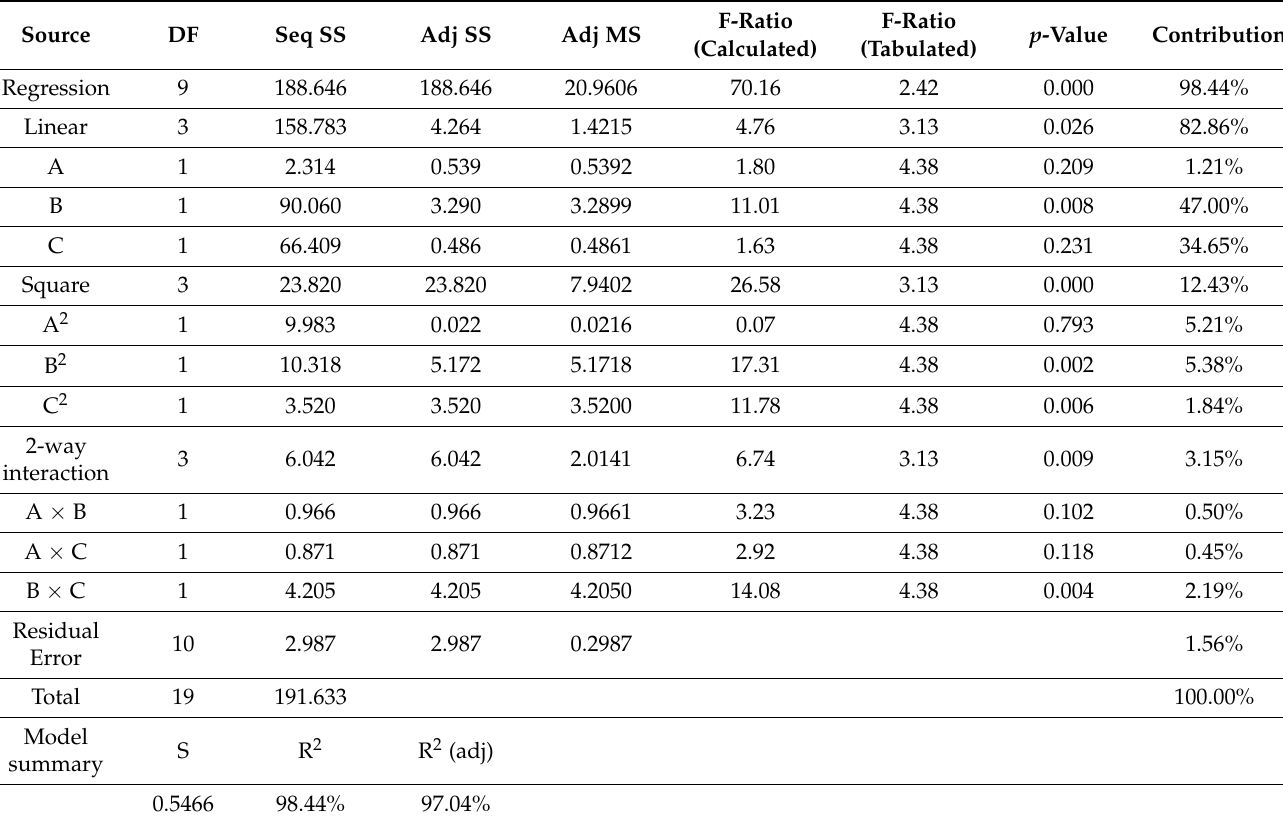
Table 6. ANOVA for thrust force of carbon fabric-neat